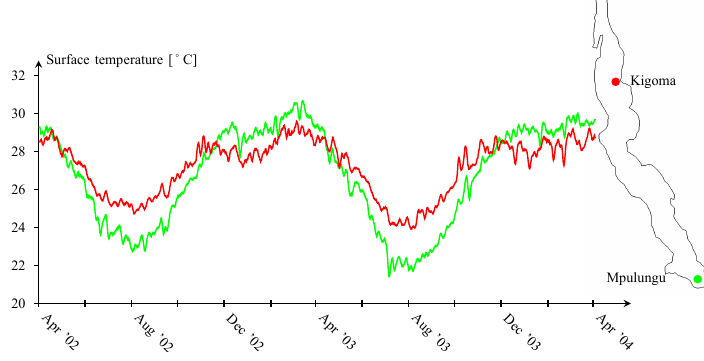
Figure 8. Time series of the surface temperature at Kigoma (red curve) and Mpulungu (green curve), as modelled by COSMO-CLM 2 (Thiery et al.,